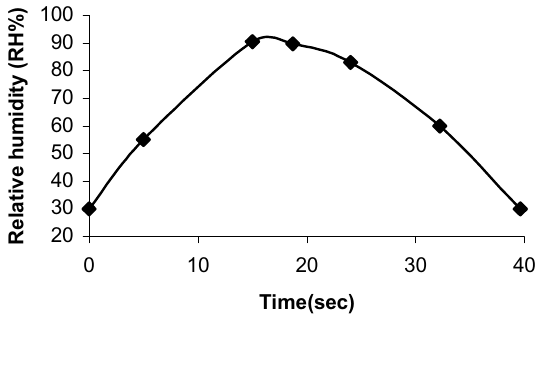
Figure 11. Time response of sample